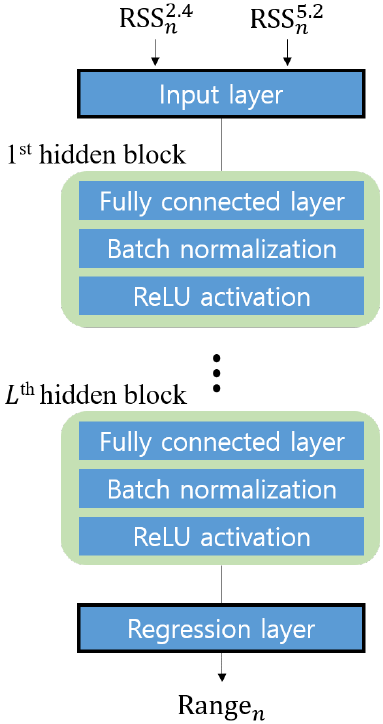
Figure 4. Neural network structure for deep